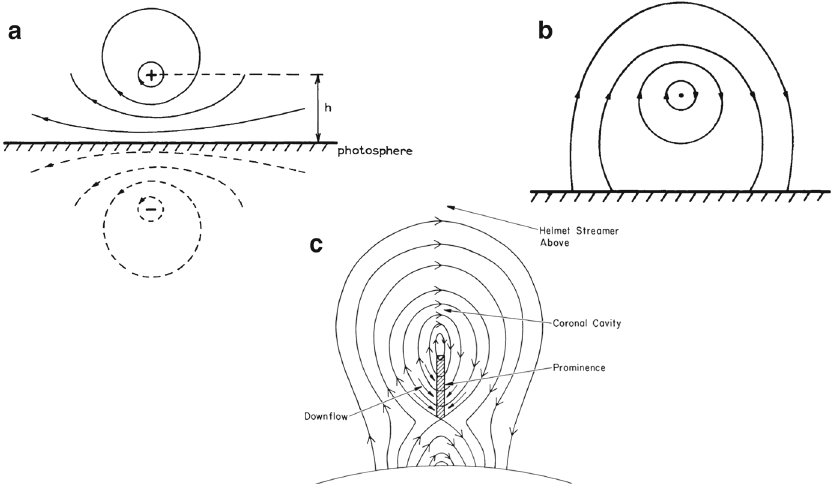
Fig. 3 Cross sections of 2.5D flux-rope type prominence models. a Kuperus and Raadu model field due to a current filament a distance h above the photosphere (with image currents), and b the same embedded within a background potential field. Image reproduced with permission from Kuperus and Raadu (1974), copyright by ESO. c Summary configuration with the addition of X-line below prominence. Note that the current associated with the prominence axis is pointing into the page. Image reproduced with permission from Pneuman (1983), copyright by D. Reidel